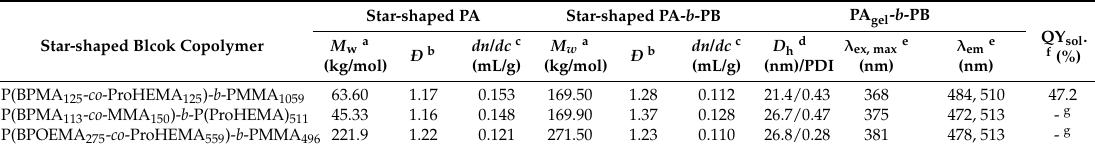
Star-shaped Blcok